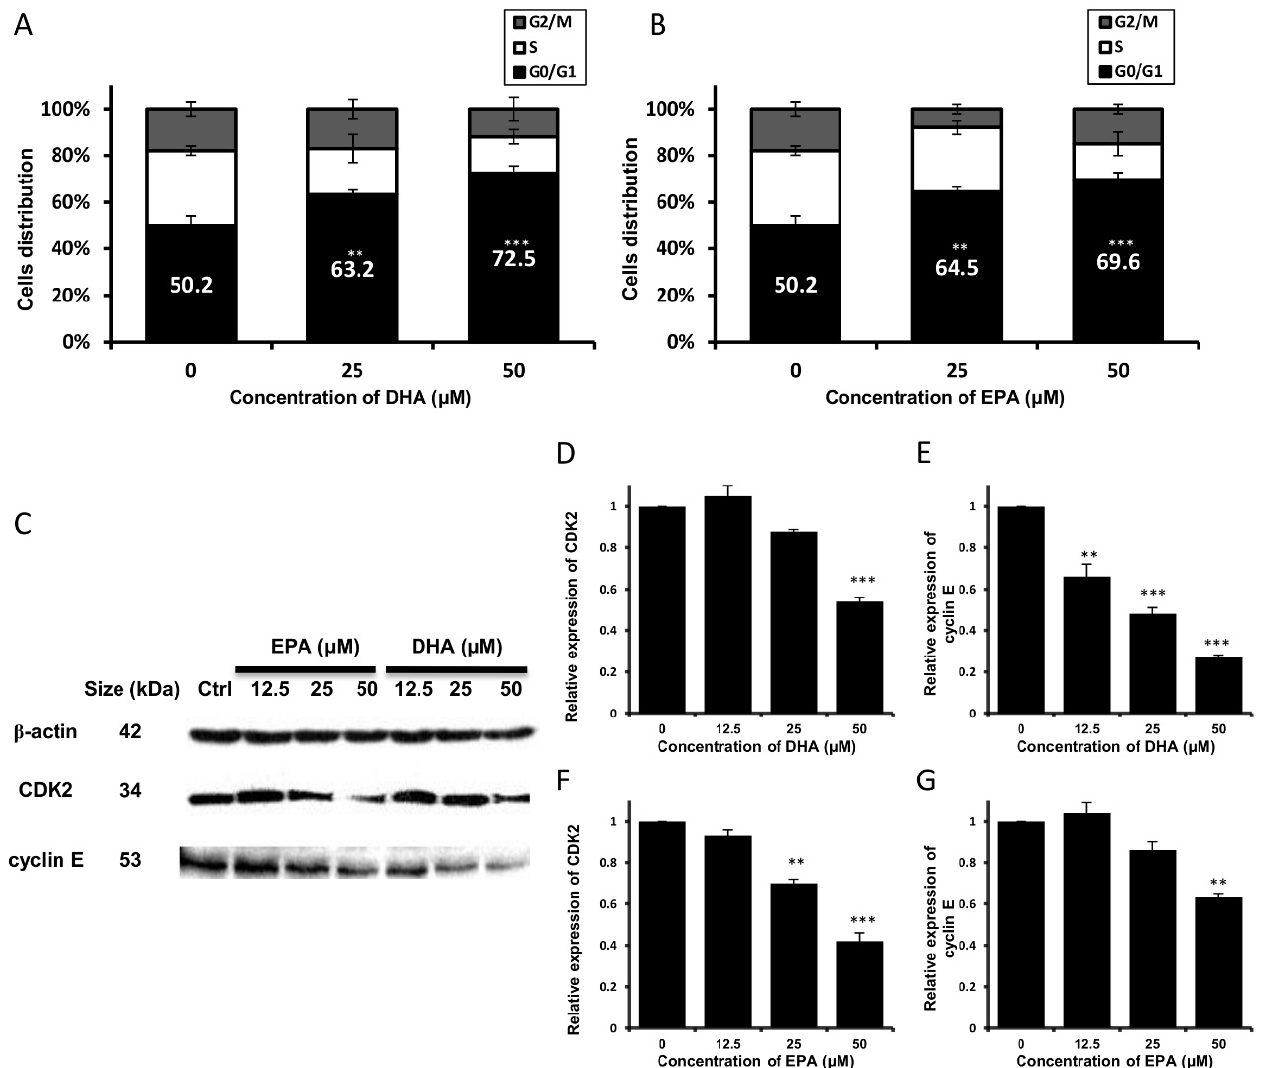
Figure 2. DHA and EPA trigger cell cycle arrest at G 0 /G 1 phase in LA-N-1 cells and down-regulate the protein expression levels of CDK2 and cyclin E. ( A , B ) LA-N-1 cells were treated with various concentrations of DHA ( A ) or EPA ( B ) for 48 hours. Cells treated with ethanol acted as the control. After incubation, cells were stained with PI, and the DNA content was analyzed by the FACSCanto flow cytometer. Cell cycle distribution was analyzed using the Verity’s Modfit LT 3.0 software. Results represent mean ± SD. ** p < 0.01; *** p < 0.001; ( C ) LA-N-1 cells were incubated with various concentrations of EPA (Lanes 2, 3 and 4) or DHA (Lanes 5, 6 and 7) for 48 hours. Cells treated with ethanol (Lane 1) acted as the control. Protein expression levels of CDK2 and cyclin E were assayed by Western blotting with β-actin served as an internal control. The relative protein expression levels of CDK2 and cyclin E in DHA-treated cells ( D , E ) and EPA-treated cells ( F , G ) as compared to β-actin were quantified. The results are expressed as relative protein expression levels ± SD. ** p < 0.01, *** p < 0.001.